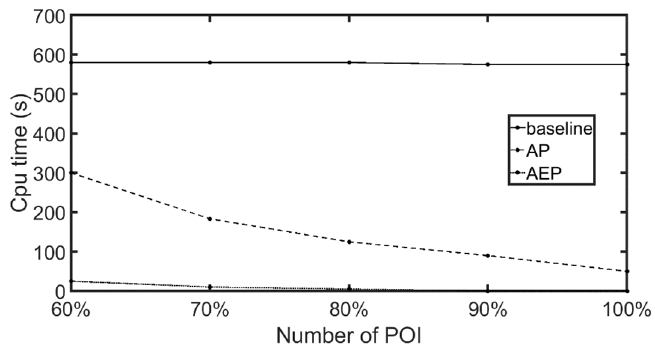
Figure 20. Computation time for queries with different